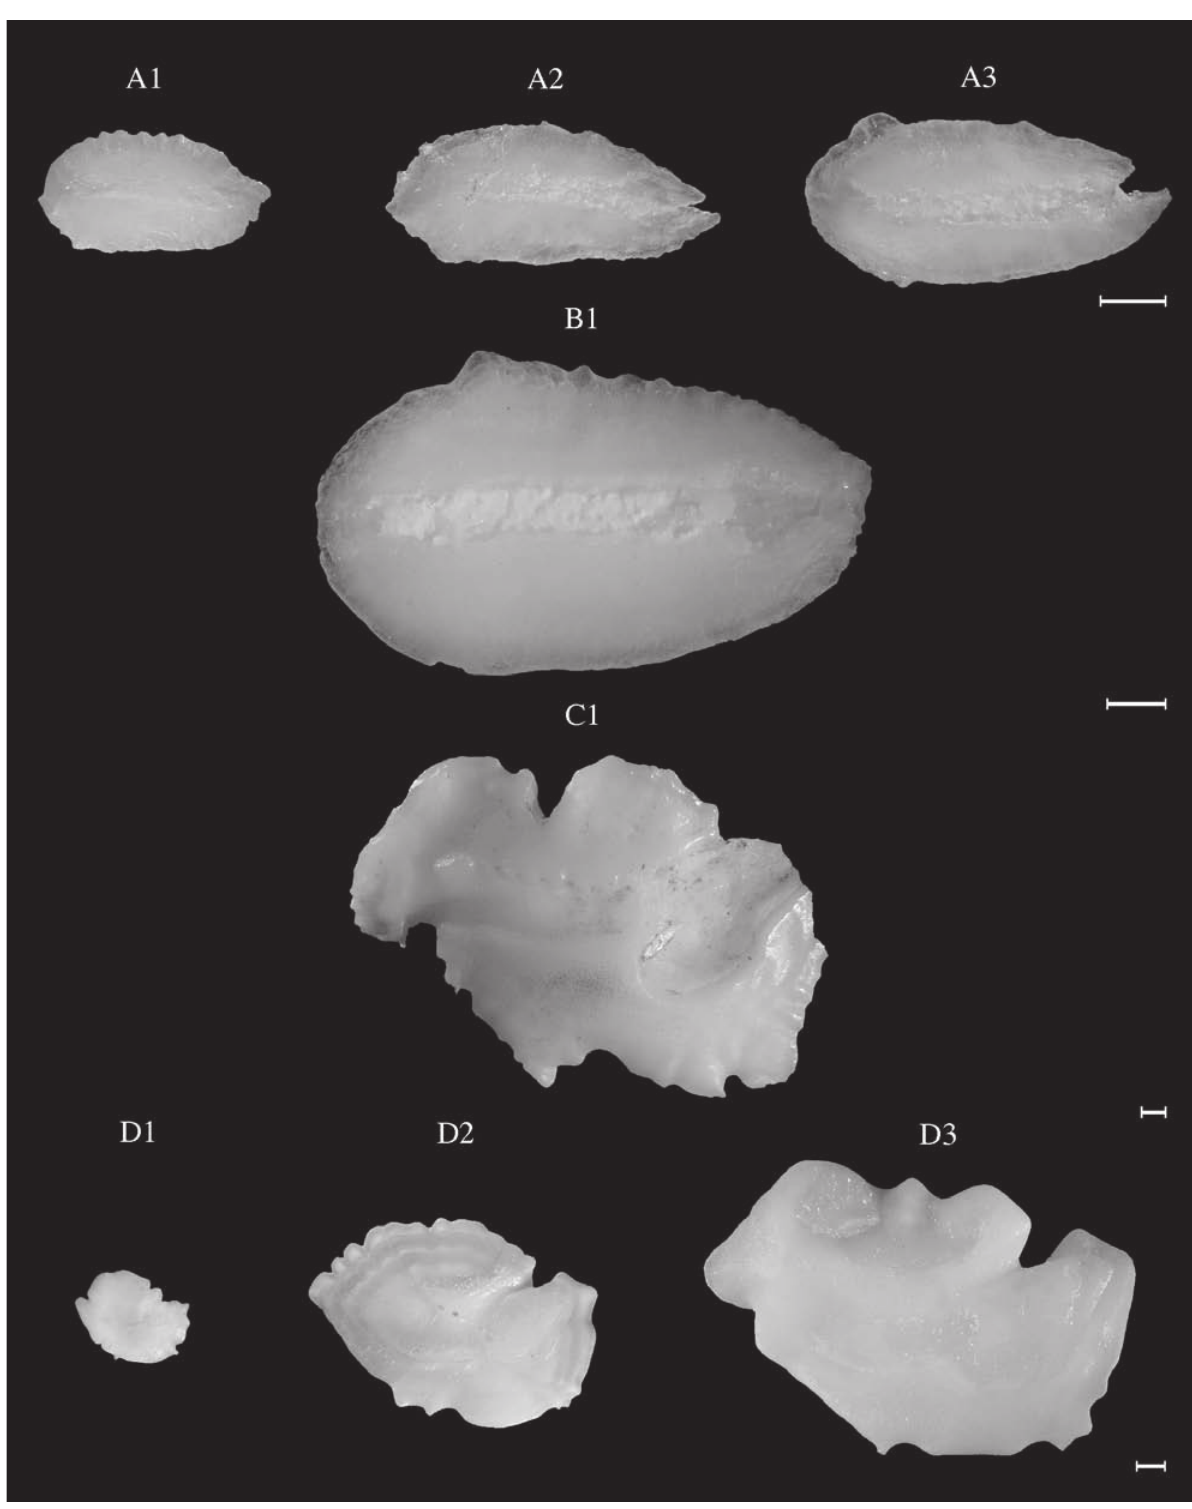
Fig. 37. – Belone belone . TL: A1, 32.7 cm (NEA); A2, 42.7 cm (CEA); A3, 50.0 cm (CEA). Tylosurus acus (CEA). TL: B1, 91.5 cm. Gephyroberyx darwini (CEA). TL: C1, 30.0 cm. Hoplostethus mediterraneus. TL: D1, 5.8 cm (NEA); D2, 15.5 cm (CEA); D3, 26.0 cm (WM). Scale bar = 1